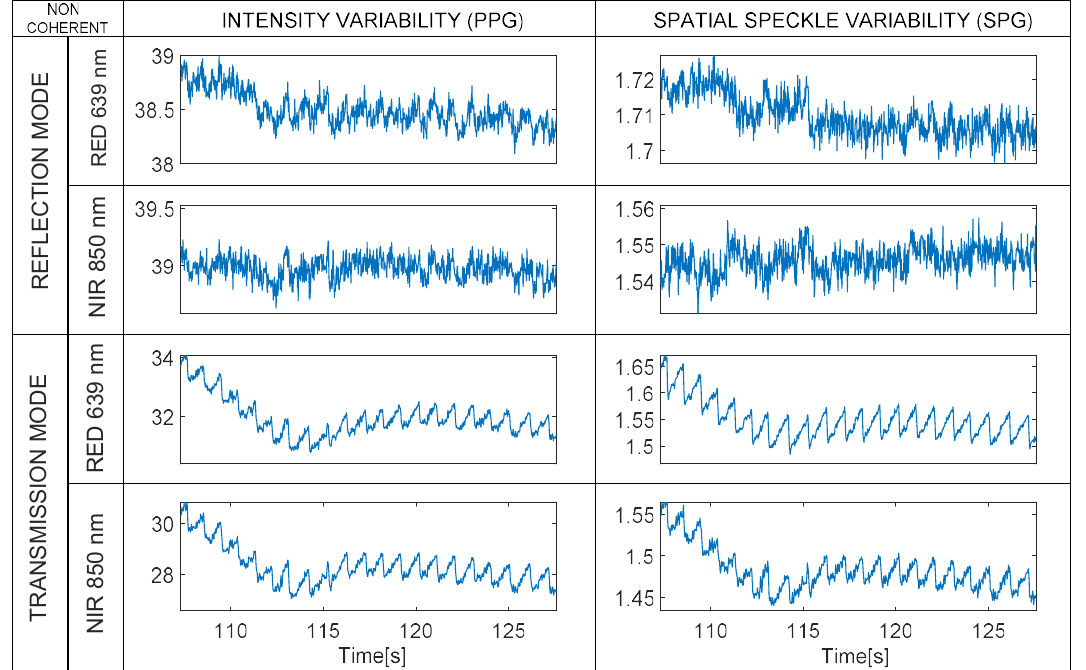
Figure 14. Non-coherent mode. Synchronous rPPG ( left ) and rSPG ( right ) signals extracted from the 4 multiplexed LED light sources (1200 μs integration time). Note that raw waveforms are displayed without vertical inversion—PPG and SPG synchronous signals from a random subject with 1200 µ s integration time.